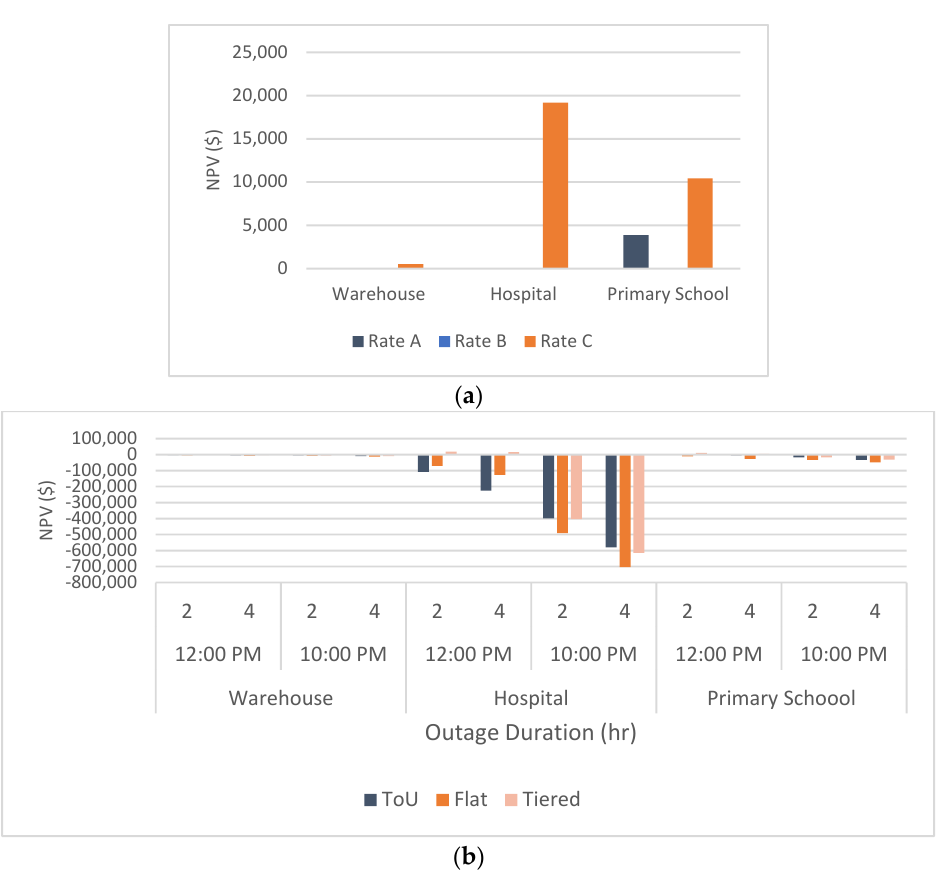
Figure 3. Phoenix, AZ region—( a ) financial and ( b ) resilience results. Table 2. Positive NPV results for the commercial loads in the Phoenix, AZ region. Financial